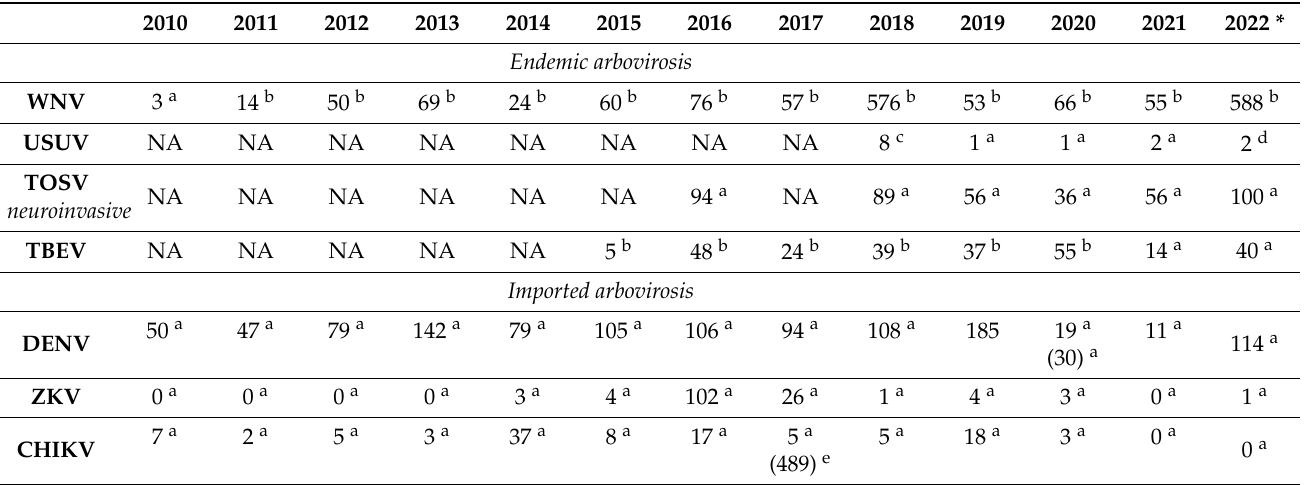
Table 2. Incidence of endemic and imported arbovirosis in Italy